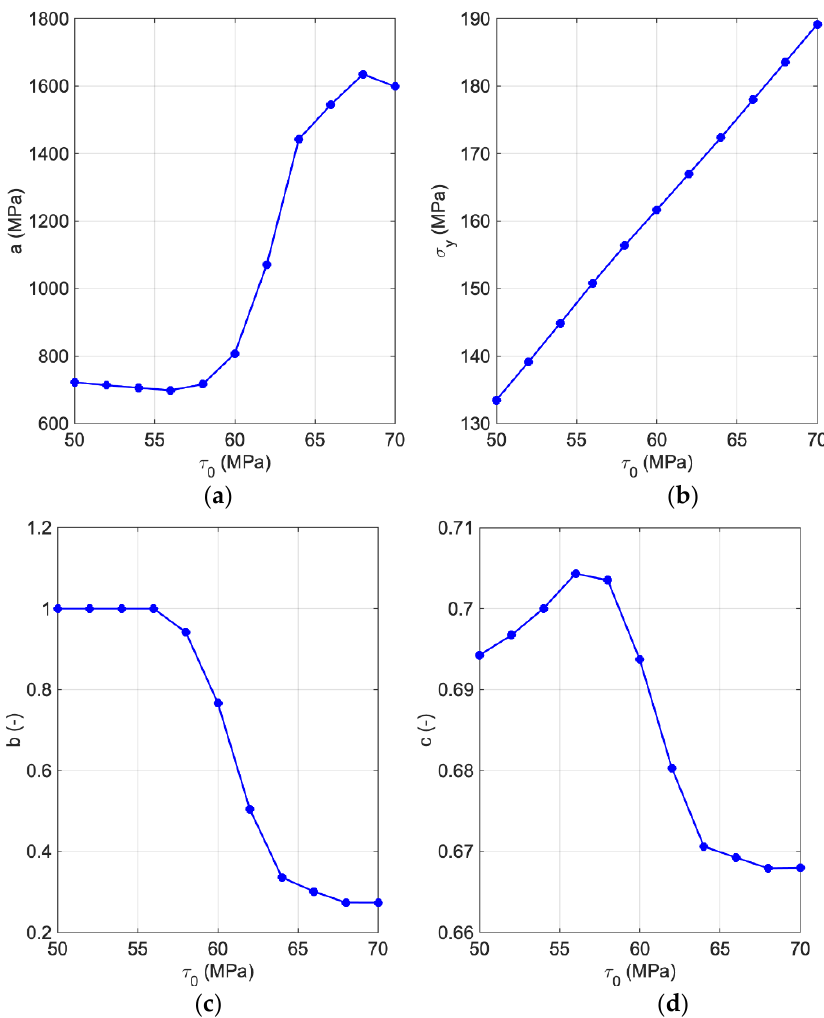
Figure 4. Variation of hardening parameters with change in τ 0 , ( a ) a , ( b ) σ y , ( c ) b and ( d ) c .